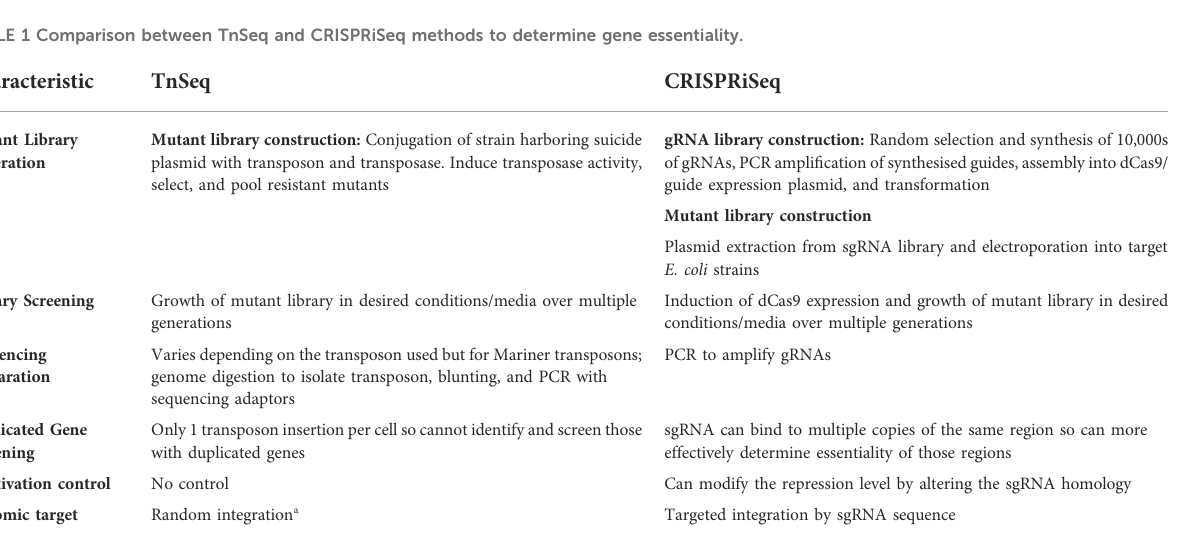
Duplicated Gene